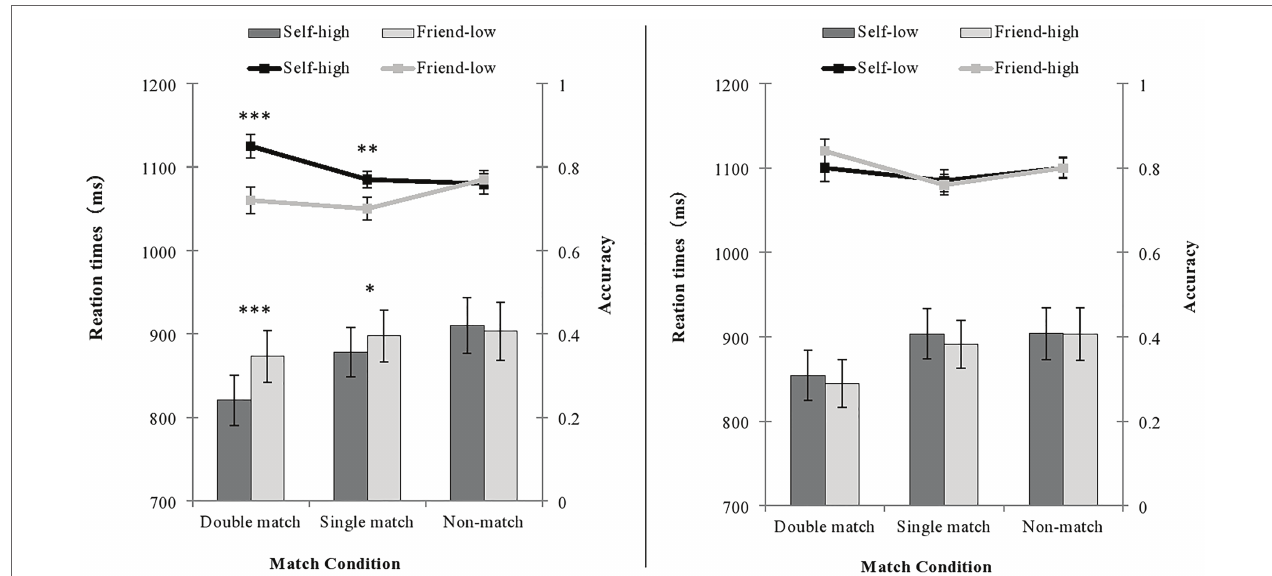
FIGURE 4 | The accuracy and RT of judgments under the condition of double salience (left) and single salience (right) in Experiment 2. The line represents accuracy, and the bars represent the RT. ∗∗∗ p < 0.001; ∗∗ p < 0.01; ∗ p <